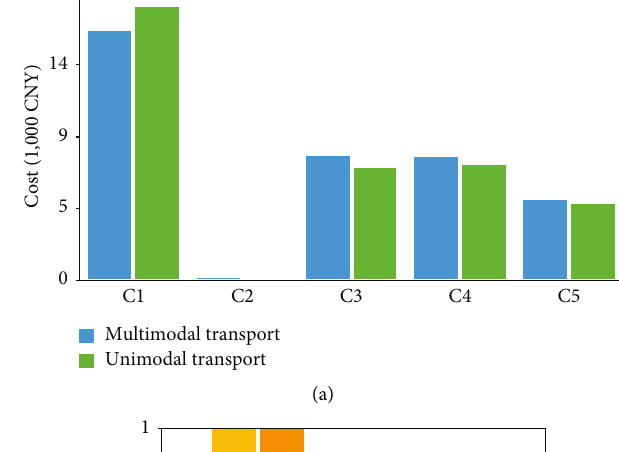
Table 6: Other parameters.